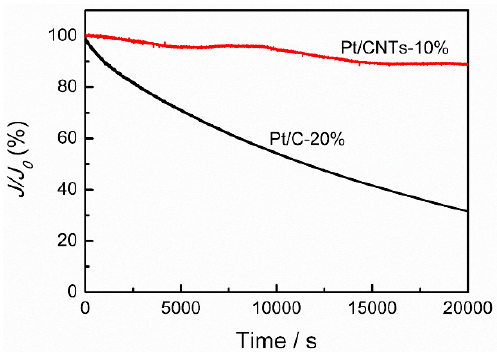
Figure 9. Relative current-time profiles of Pt NCs/CNTs-10% and Pt/C-20% in 0.1 M O 2 -saturated HClO 4 .